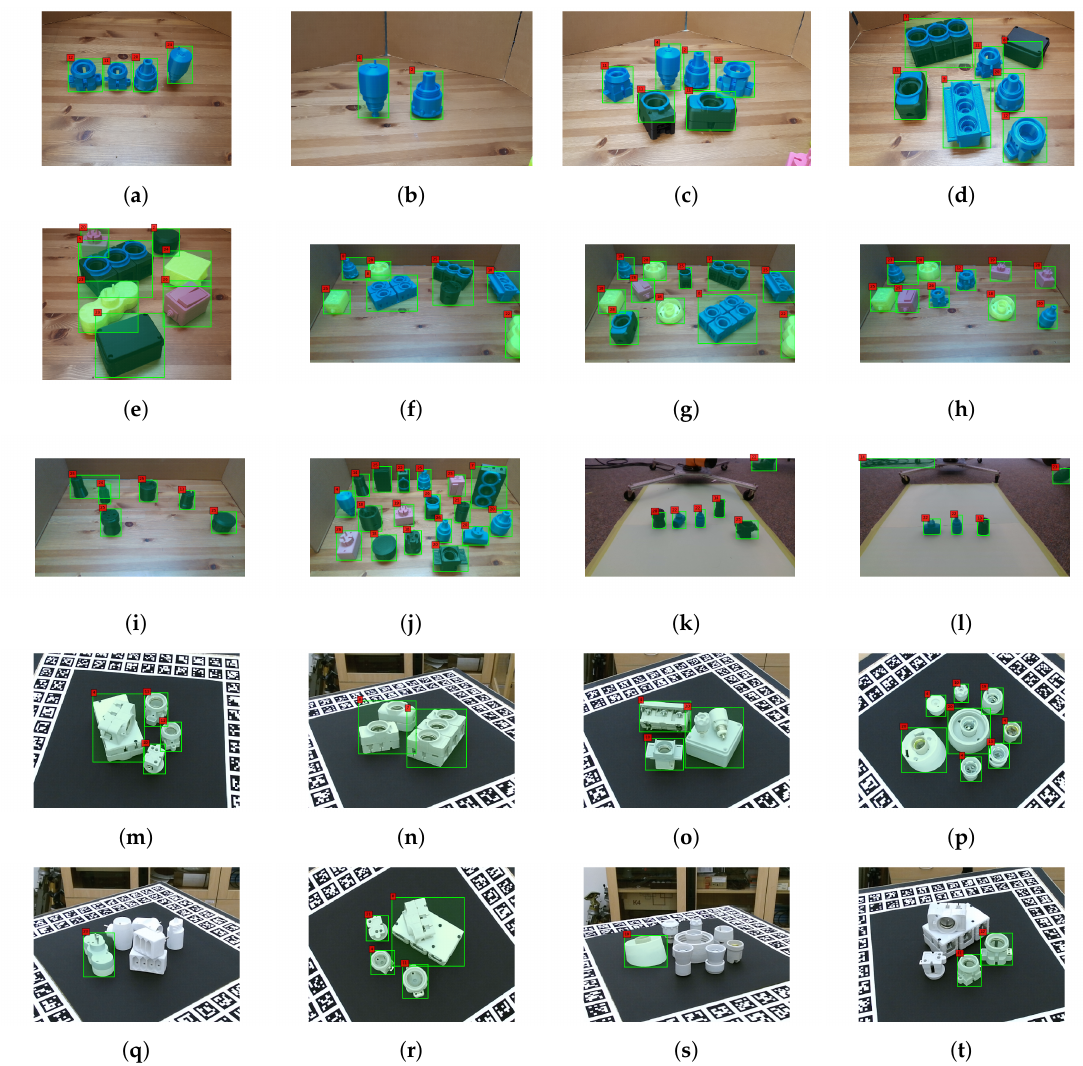
Figure 11. ( a – j ) Recognition results on our first setting’s test scenes, ( k , l ) recognition results on our second setting’s test scenes, and ( m – t ) recognition results on Tless test